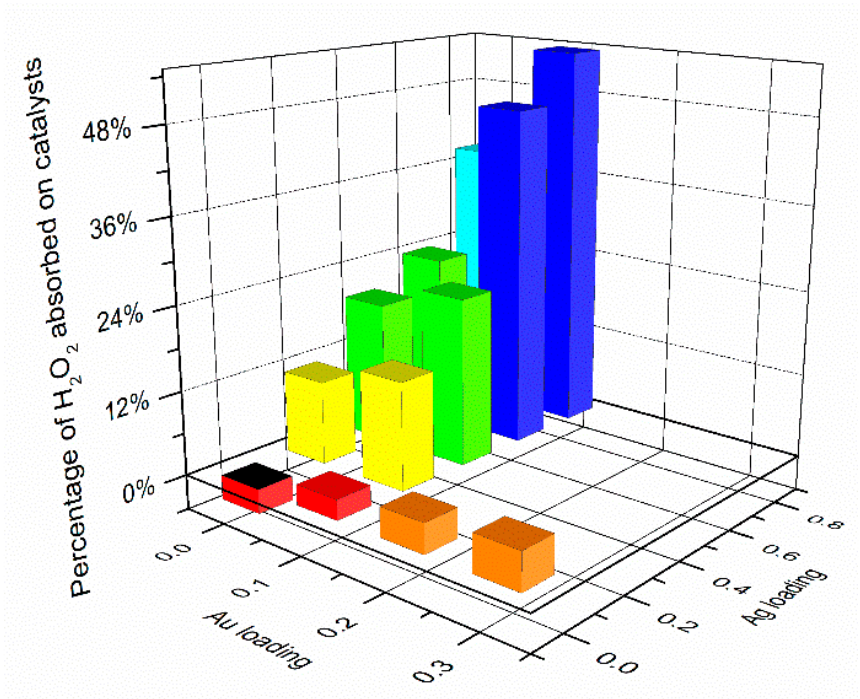
Figure 6. Percentage of H 2 O 2 adsorbed on modified ZnO after 1 h dark stirring (50 mg catalysts in 100 mL 1000 µ M H 2 O 2 solution).